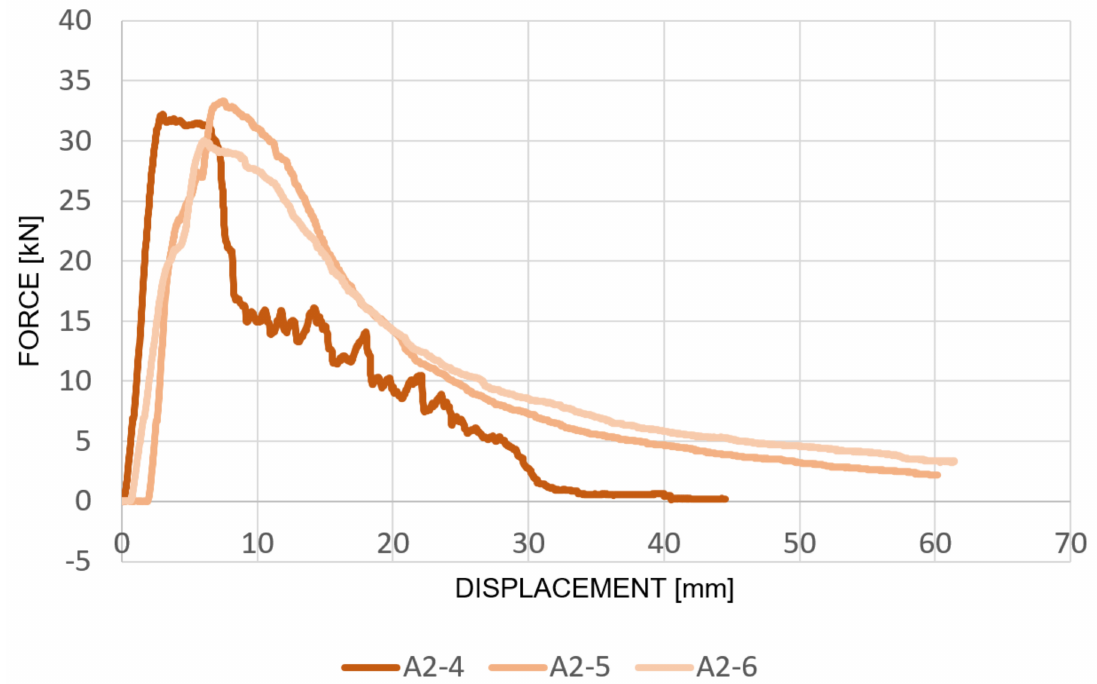
Figure 20. Graphic evaluation of laboratory tests of static point loading of the batch of specimens A2 tested after 251 days after